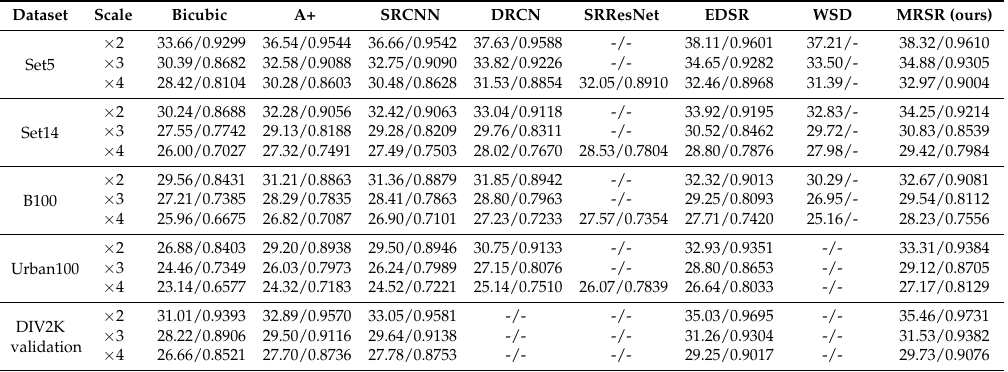
Table 2. Benchmark test results (PSNR(dB)/SSIM) on datasets Set5, Set14, B100, Urban100, and DIV2K for scale factor × 2, × 3, × 4. Bold indicates the best